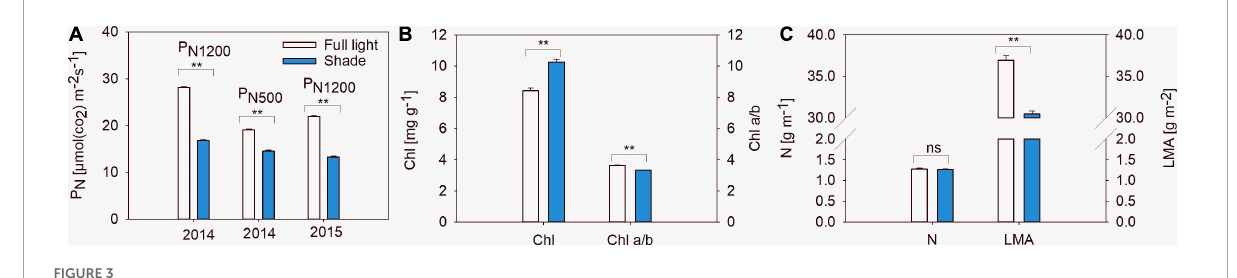
FIGURE3 Net photosynthetic rates at 500 µ mol m – 2 s – 1 (P N500 ) and 1,200 µ mol m – 2 s – 1 (P N1200 ) (A) , chlorophyll concentration (Chl) and Chl a/b ratio (Chl a/b) (B) , nitrogen (N) concentration and leaf mass per unit area (LMA) (C) of 20 soybean varieties grown under shade and the control conditions in 2014. Traits were expressed as mean ± standard errors from 20 cultivars in 2014 and 14 cultivars in 2015. ** represent significant difference at 0.01 level.